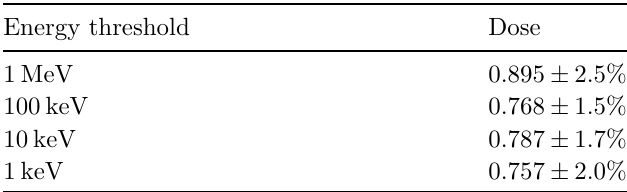
Table 3. Parametric analysis changing the energy thresh- olds of the simulations (PRECISIO defaults): dose in the GO of the RadFET, in 10 (cid:4) 14 Gy/pot. SiO 2 Energy threshold